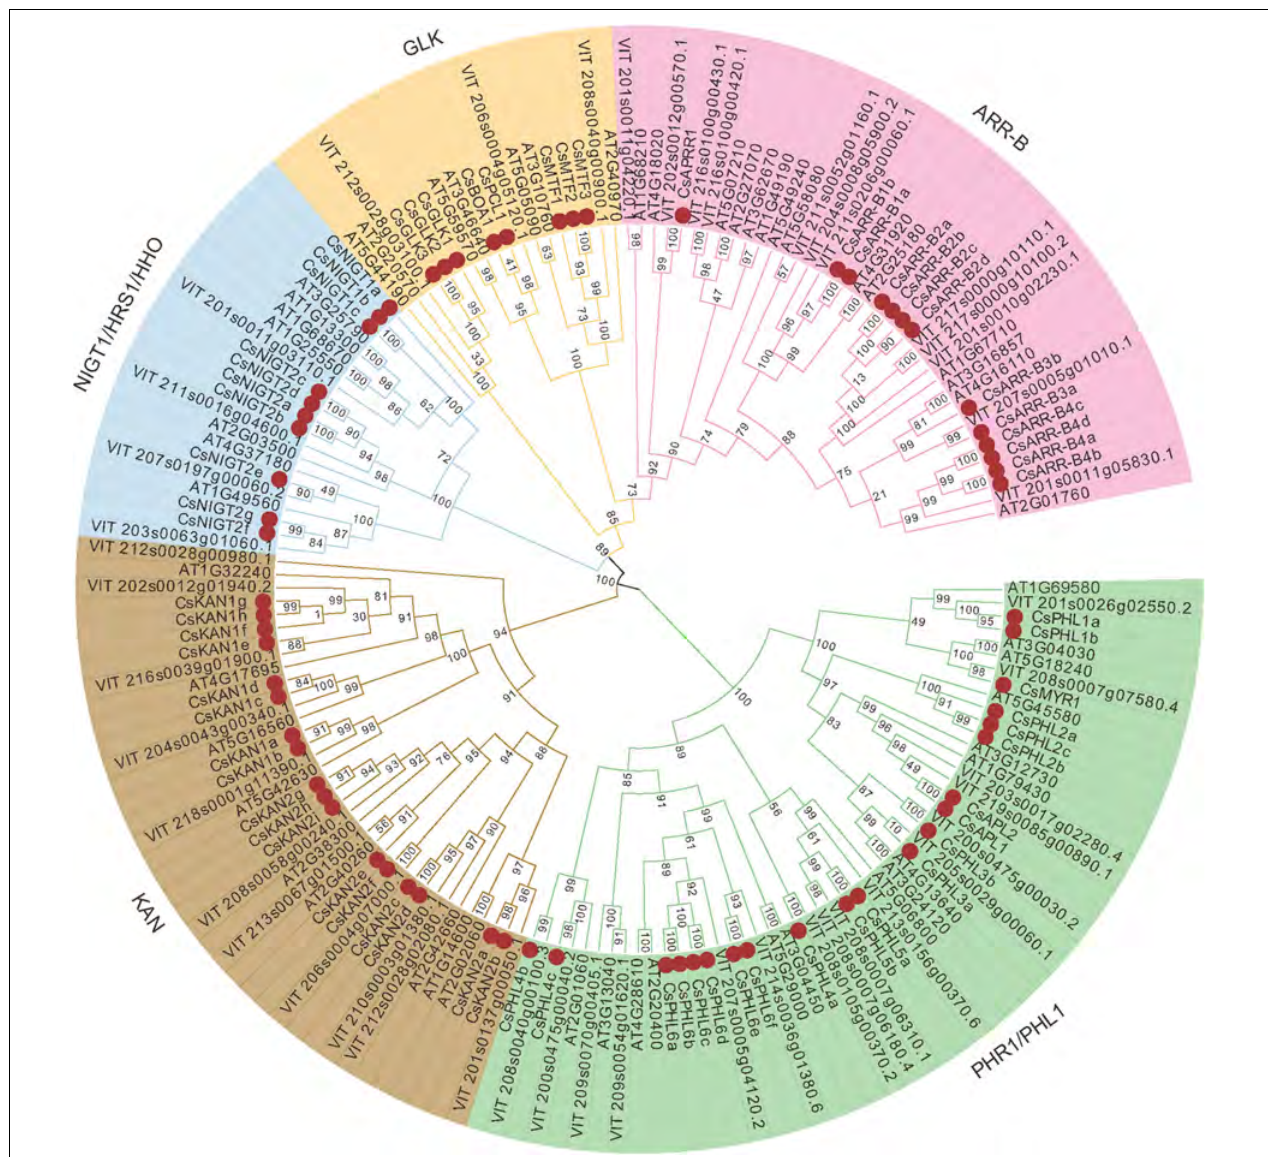
FIGURE 2 | Phylogenetic tree analysis of GARP proteins from tea plant, Arabidopsis and Vitis vinifera constructed by the maximum likelihood (ML) method. The CsGARPs are marked by red